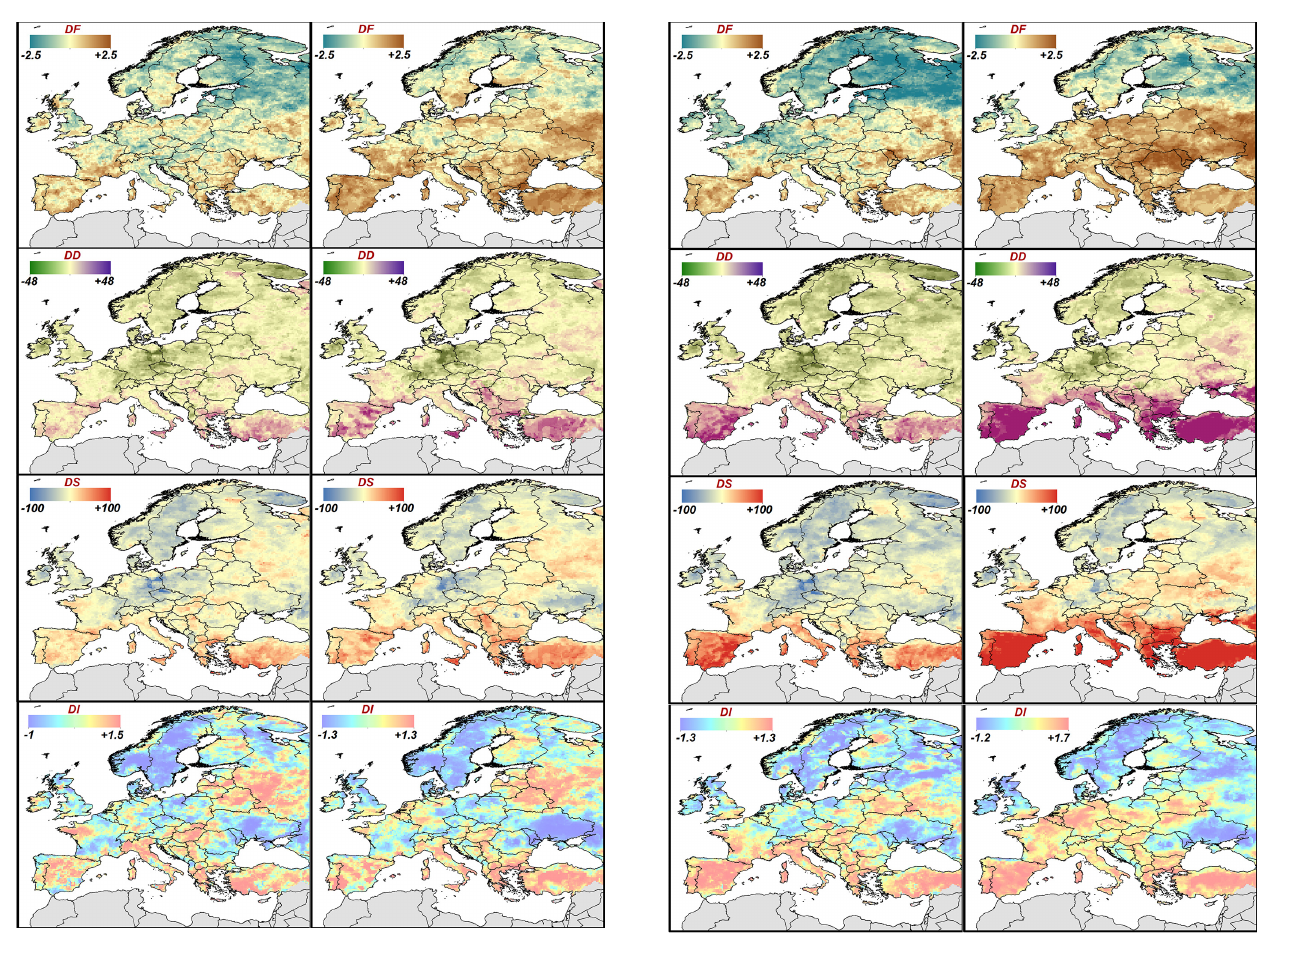
Figure 2. Comparisons between far future and recent past for the frequency (DF), duration (DD), severity (DS), and intensity (DI) of drought events, according to the SPI-12 (left panel) and the SPEI-12 (right panel). All the values are expressed per